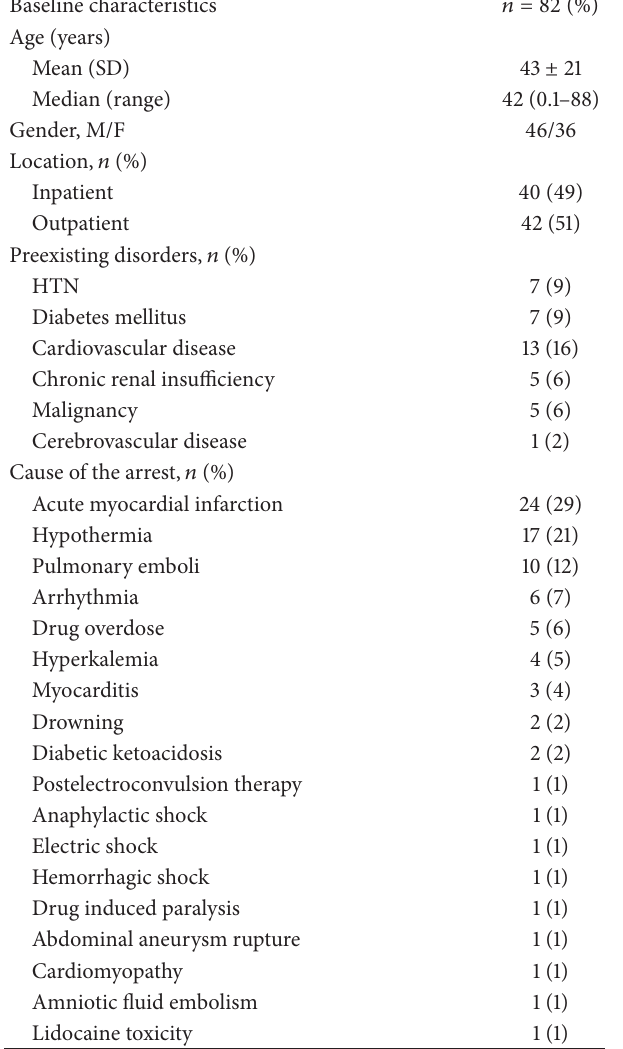
Table 1: Baseline characteristics of the 82 patients.